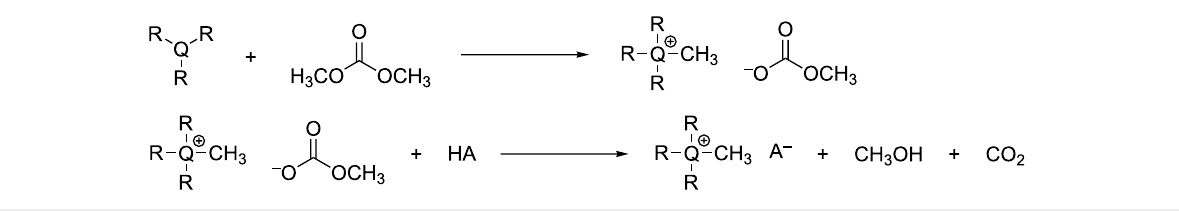
Scheme 3: Top: Green methylation of phosphines and amines by dimethyl carbonate (Q = N, P). Bottom: anion metathesis of methyl carbonate onium